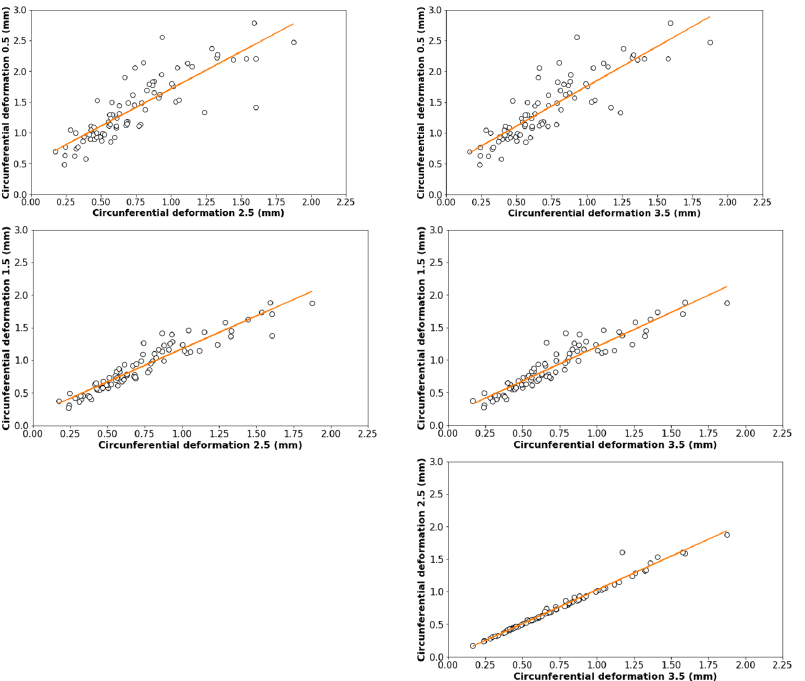
Figure 14. Correlation between different values of circumferential deformation.